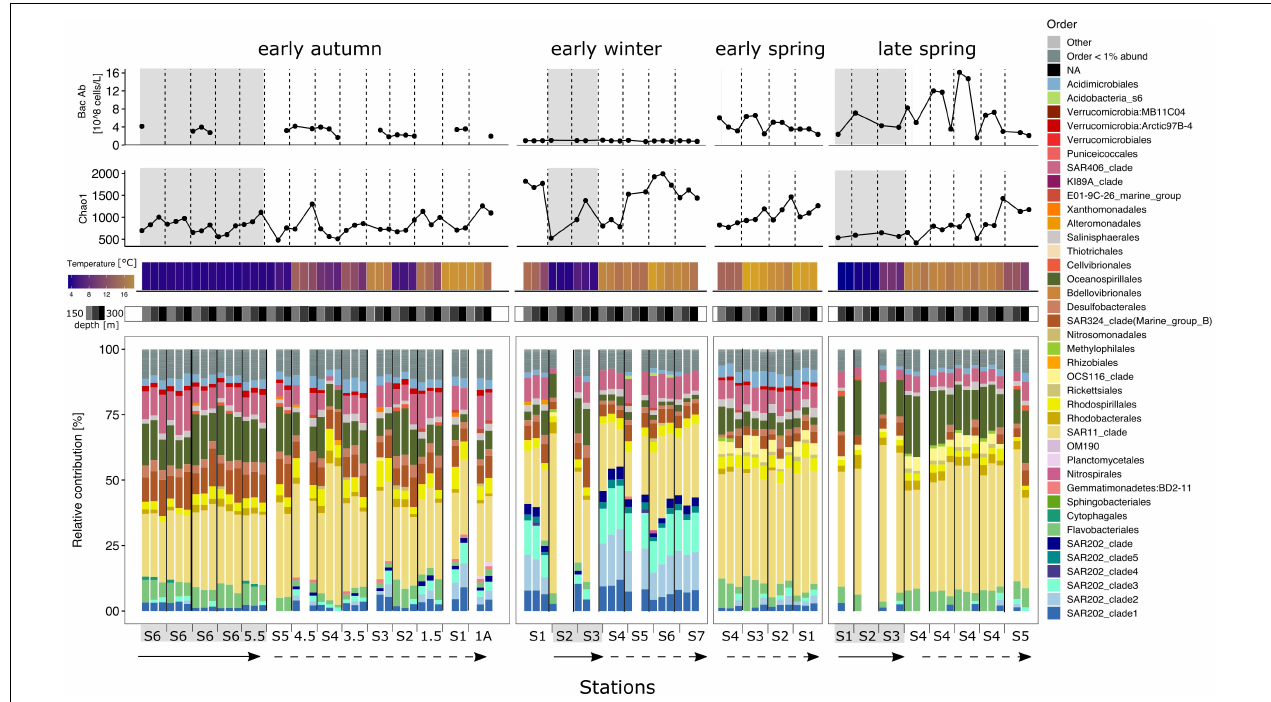
FIGURE 5 | Environmental metadata and stacked bar plots of the taxonomic relative contributions to the bacterioplankton fraction for each station within each seasonal campaign in the upper mesopelagic. Top two panels: bacterioplankton abundance and Chao 1 richness. Temperature and depth heatmap cells and data points in the three line charts are aligned to the bacteria community composition representation below. Base bar plots depict the relative contributions of the different taxonomic groups within the bacterioplankton fraction. Bars are organized by station from left to right in a north to south direction indicated by the straight arrow (subpolar) and the dashed arrow (subpolar), except early winter where S2 was the most northern station. Within each station, depths are organized in a descending order from 150 to 300 m following a left to right direction. Blank columns represent samples that did not overcame the minimal sequences threshold or which sample was unsuccessful to generate amplicon sequences. Gray background shading indicates that the profile is biologically categorized as subpolar, while no shades represents subtropical.